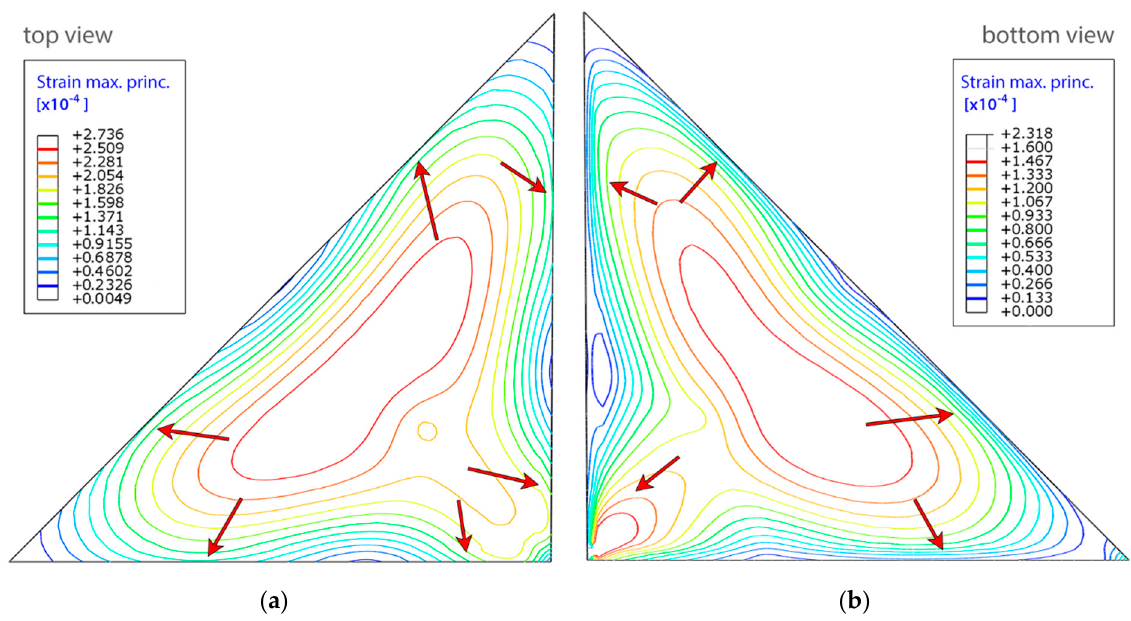
Figure 18. Contour maps of the distribution of the maximum principal strains induced by a negative pressure gradient: ( a ) view from the top; ( b ) view from the bottom on panes separated by a PVB interlayer.